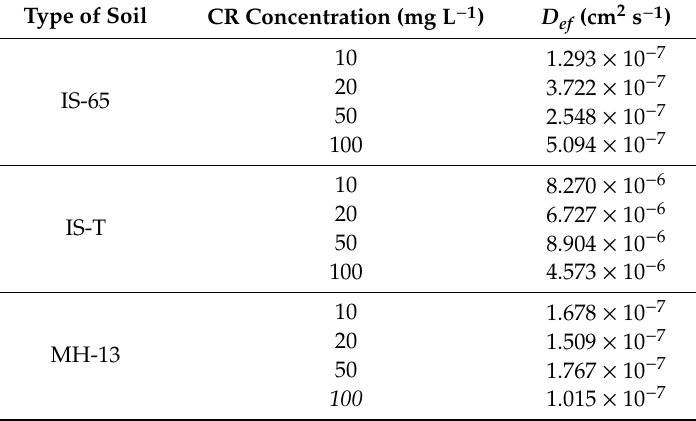
Table 6. E ff ective di ff usion coe ffi cients ( D ef ) of Congo red sorption on tested soil, for di ff erent initial concentrations of